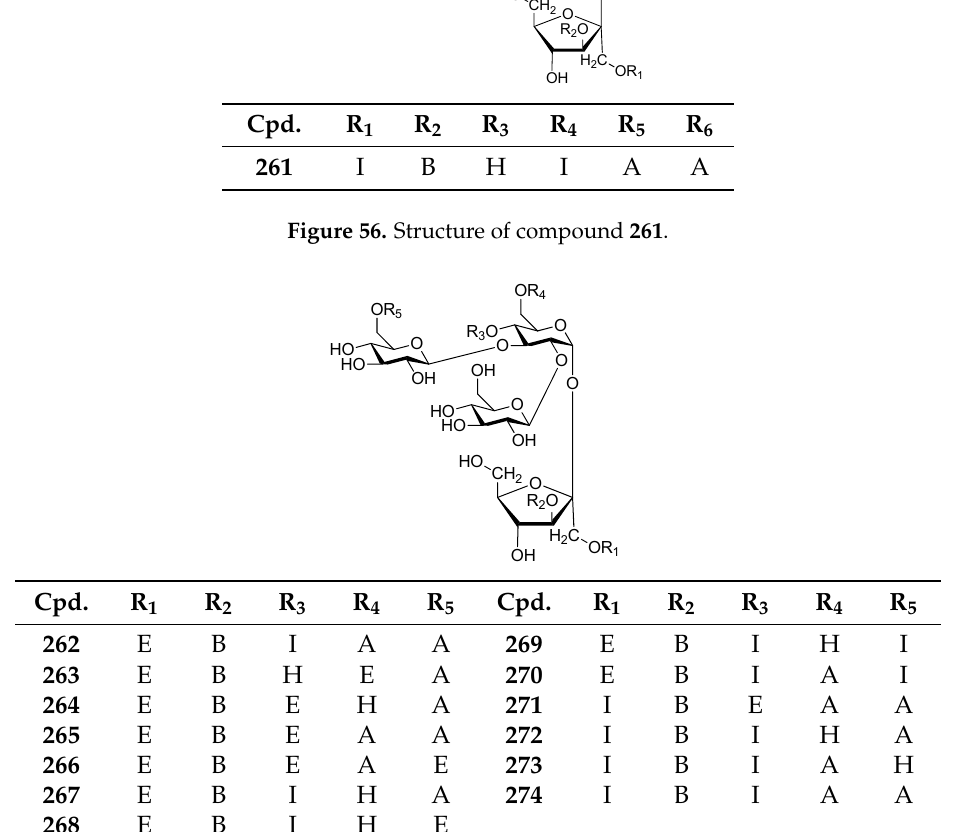
Figure 57. Structures of compounds 262 – 274 .